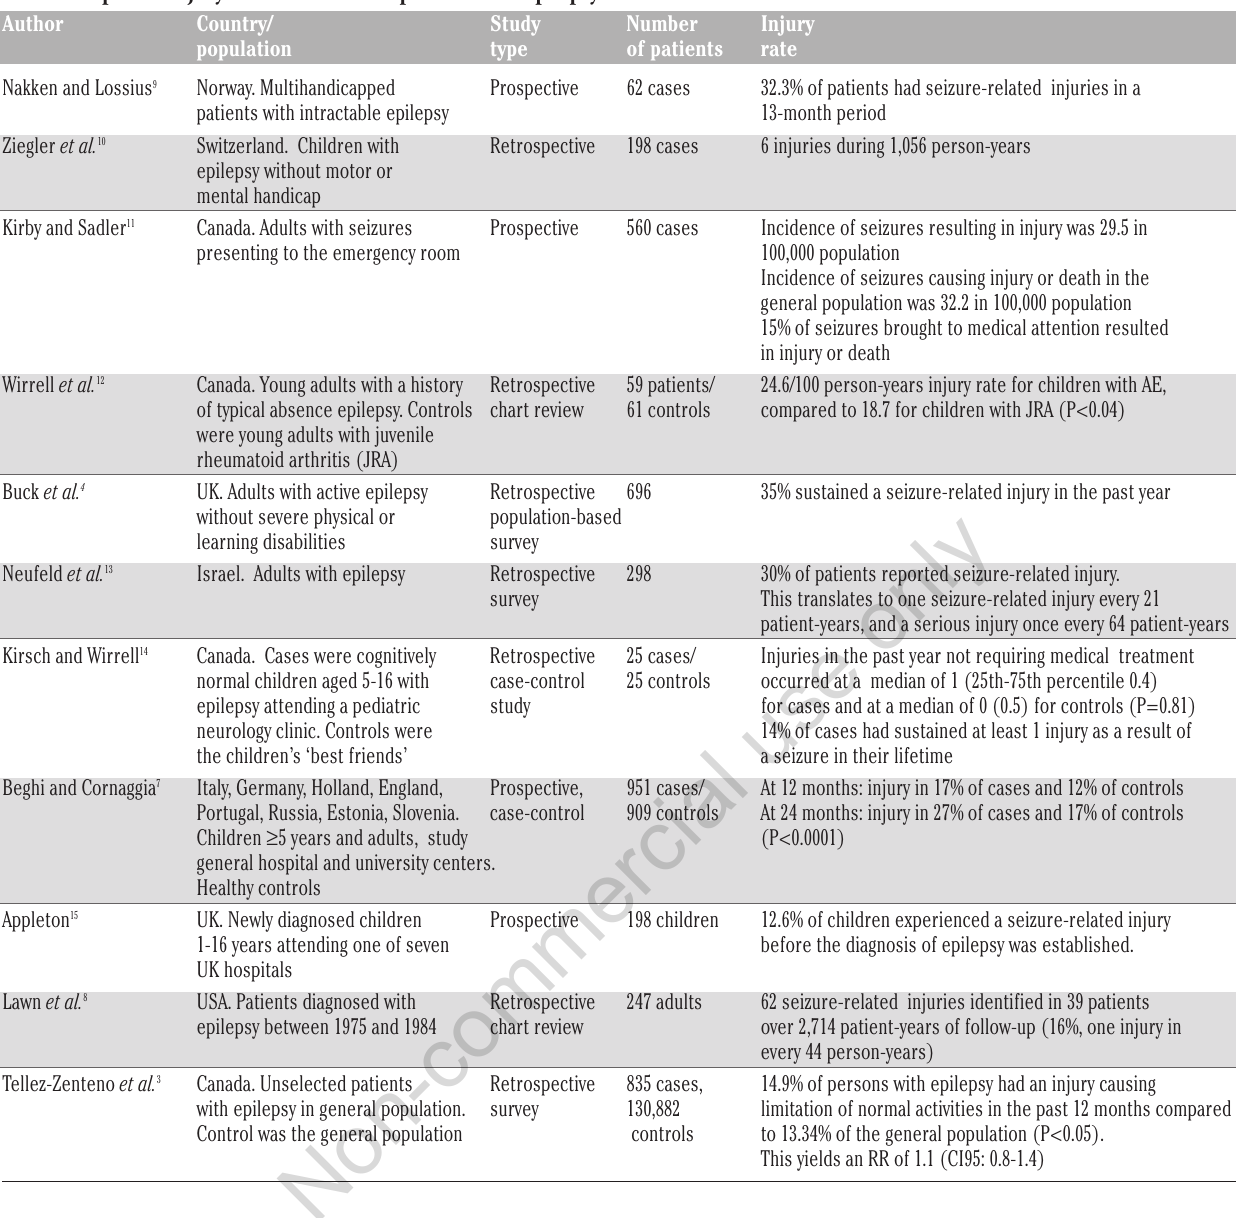
Table 1. Reported injury rates in studies of patients with